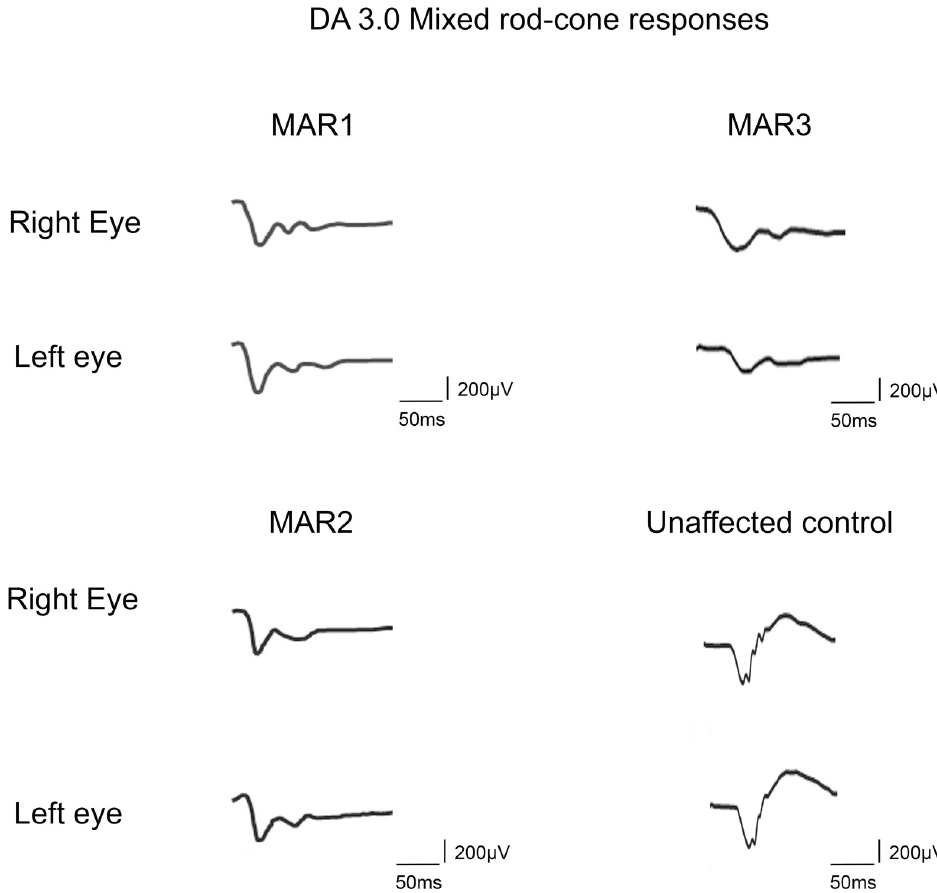
Fig 1. Full-field ERG recordings (DA 3.0). Ff-ERG responses to a 3.0 cd.s.m 2 flash under dark-adapted (DA) conditions from an unaffected subject and the three patients with a clinical diagnosis of melanoma-associated retinopathy (MAR). All three patients had a severely reduced b-wave with an electronegative